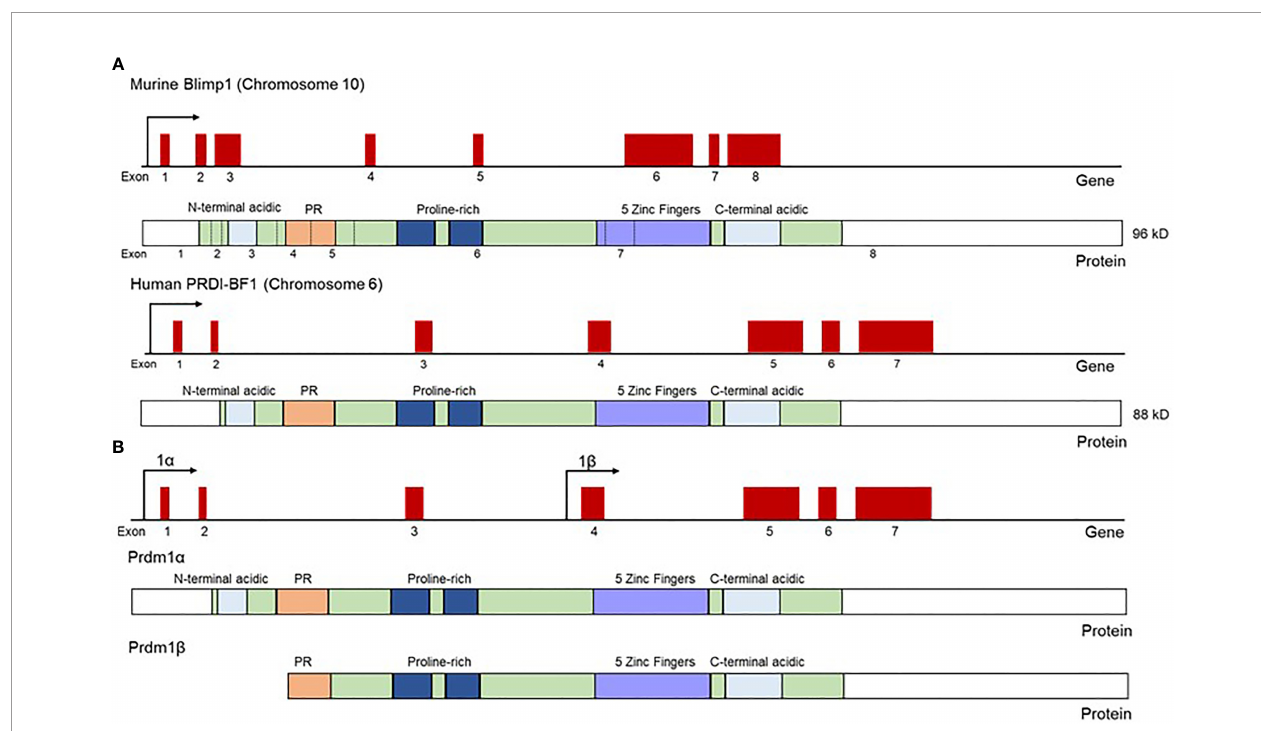
FIGURE 1 | Schematic representation of Blimp1 and PRDI-BF1 mRNA and protein structure in mouse and human. (A) Both human and murine homologs of Blimp1 contain fi ve Krüppel-type zinc fi ngers, two acidic regions (N and C terminal), proline-rich region and a PR domain. Murine Blimp1 contains 67 extra N-terminal amino acids compared to the human homolog PRDI-BF1, and Blimp1 and PRDI-BF1 are 90% identical to each other and can be used interchangeably in functional assays. Gene diagrams show exons as raised red boxes. Protein diagrams show exonic regions (green), acidic regions (light blue), PR domain (orange), proline-rich region (dark blue) and zinc fi ngers (purple). (B) The full-length Blimp1 transcript encodes Blimp1 a , while a truncated transcript encoded from an alternative promoter (beta promoter) was name Blimp1 b , and the resultant Blimp1 b protein is 700 amino acids long and lacks the N-terminal acidic region and part of the PR domain found in the full length Blimp1 a protein. Protein diagrams show exonic regions (green), acidic regions (light blue), PR domain (orange), proline-rich region (dark blue) and zinc fi ngers (purple). Adapted from Györy et al. (4) and Tunyaplin et al.